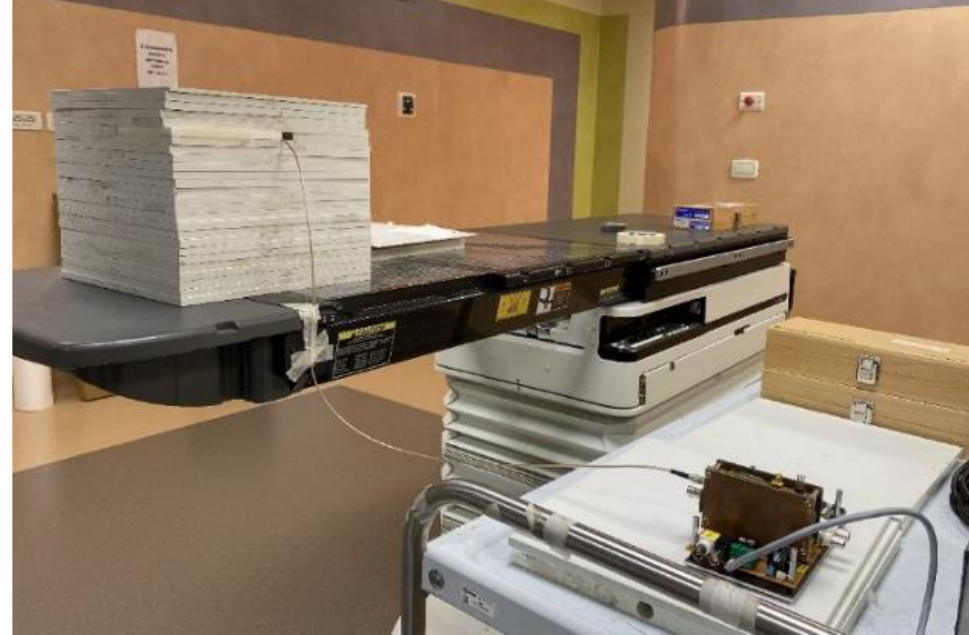
Figure 4. Picture of the characterization setup under high-energy pulsed X-rays. The dosimeter, placed inside a solid Plexiglass ® phantom (on the left), is positioned at the isocenter of LINAC, under a 10 × 10 cm 2 field.